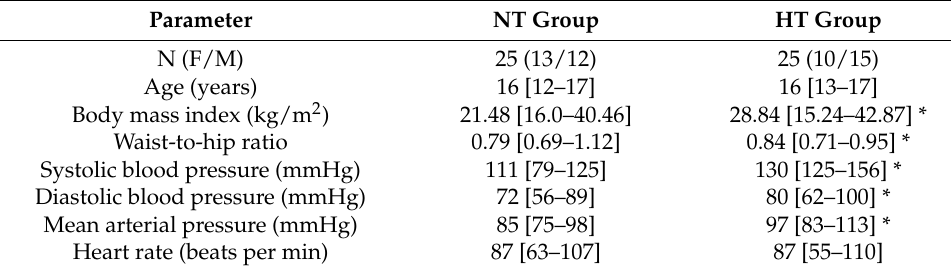
Table 1. Anthropometric and hemodynamic parameters of the subjects.